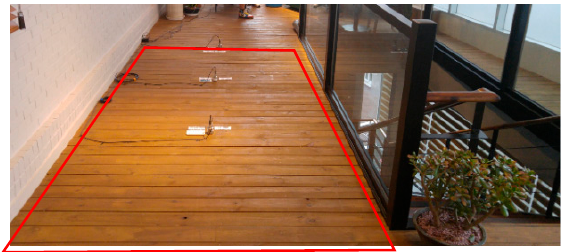
Figure 18. Cladding completion in Nambuk Church.